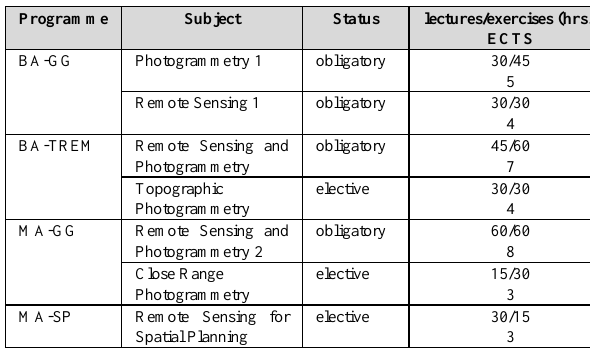
Table 1: Photogrammetry and Remote Sensing subjects in the curriculum of University of Ljubljana, Faculty of Civil and Geodetic Engineering